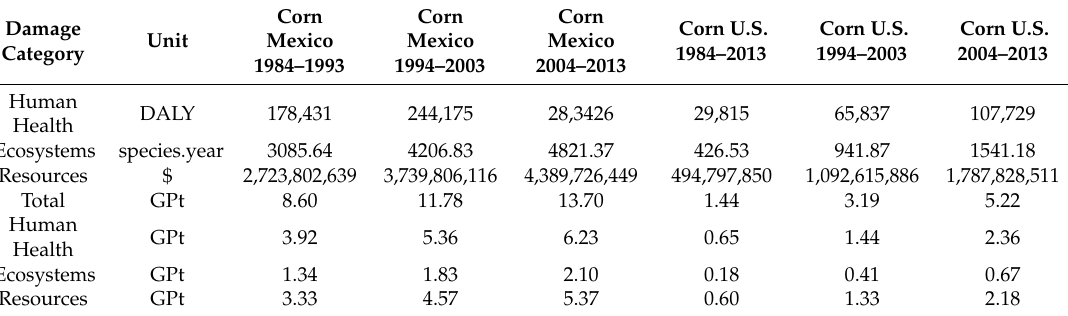
three decades of study derived from total values.